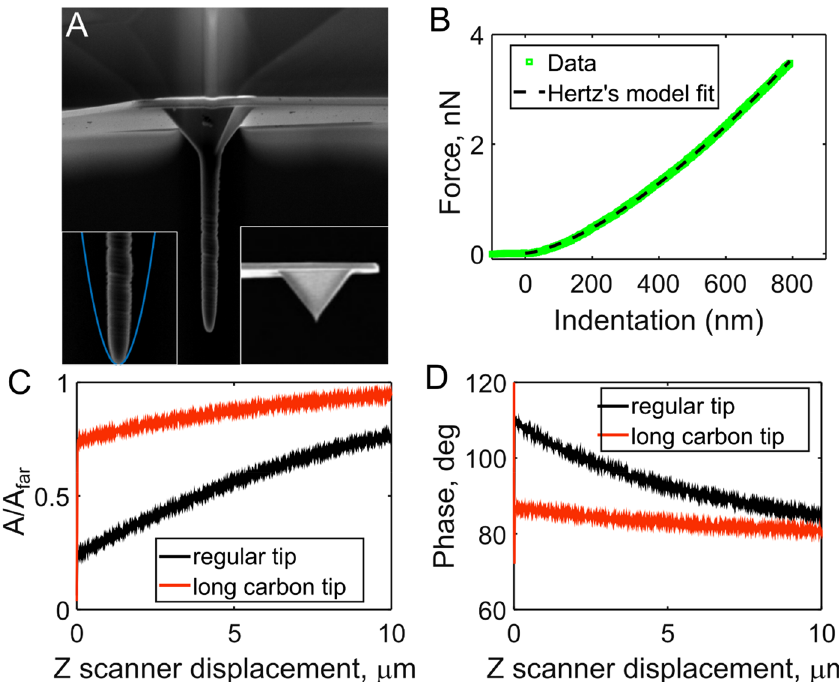
Figure 1. Cantilevers with long carbon tips. ( A ) SEM image (left inset—a fit with parabola to estimate the tip radius; right inset—a regular tip of the same cantilever type). ( B ) Force vs. Indentation curve obtained on the hydrogel fit well with the Hertz’s contact model (paraboloid). ( C ) Normalized amplitude vs. distance from the surface (glass) in the liquid (PBS). ( D ) Phase vs. distance from the surface (glass) in liquid